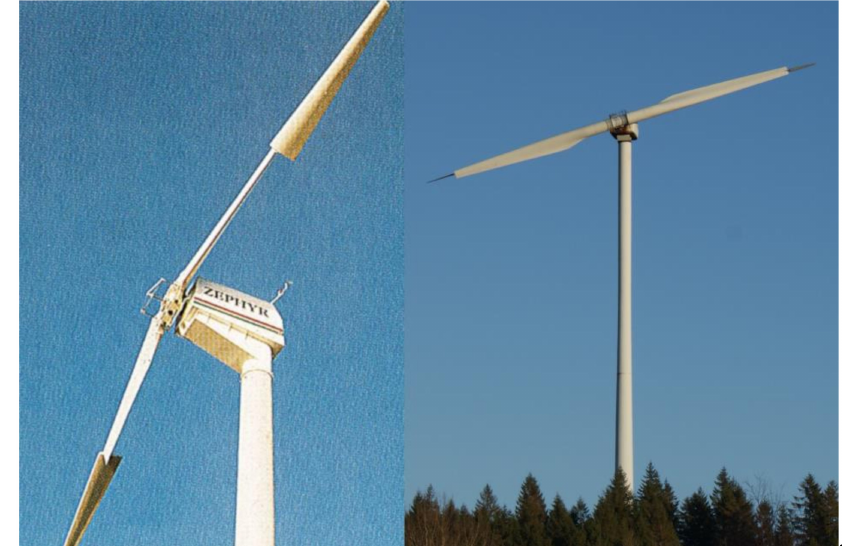
Figure 3. Zephyr and Nordic Windpower. Left: A Zephyr 250 kW near Falkenberg with the outboard section of the blade pitched. Photo used with permission from Falkenberg Energi AB. Right: A parked 1-MW Nordic 1000 near Halmstad, Halland County (2019). Photo by Erik